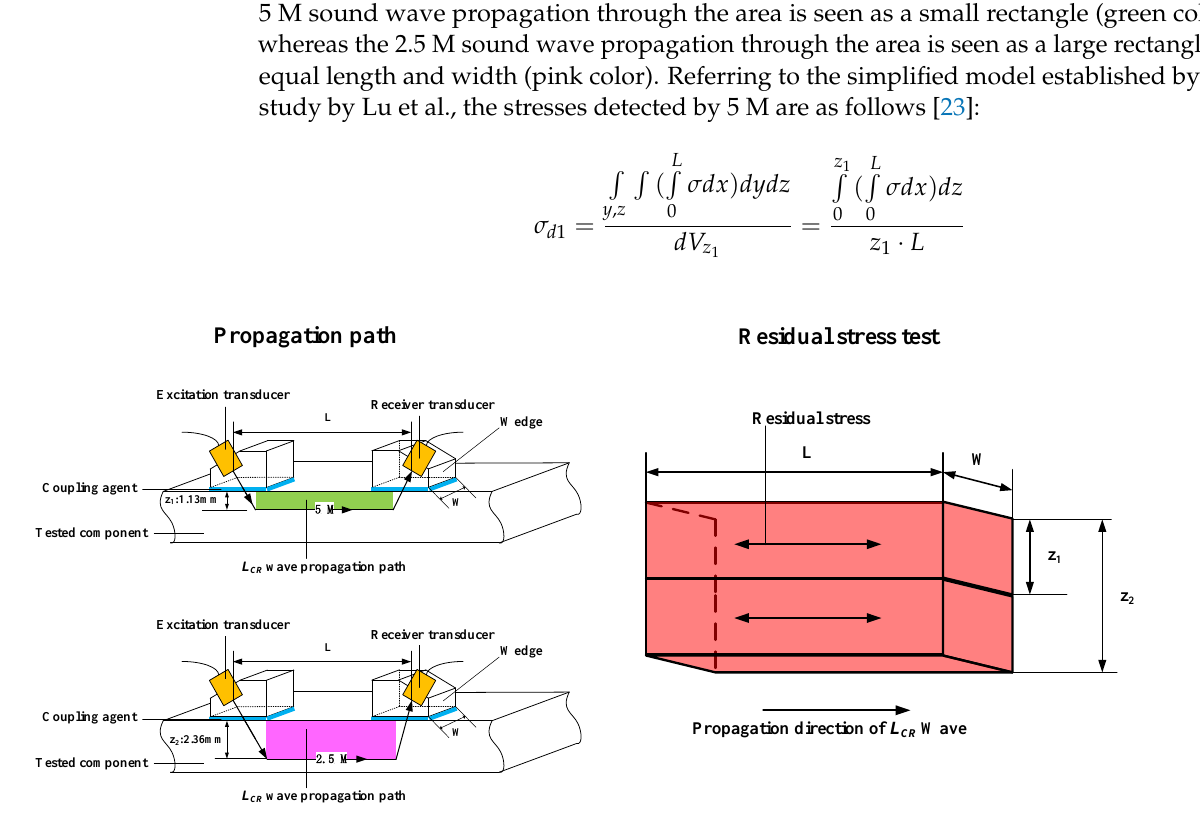
Figure 1. Schematic diagram of ultrasonic propagation path and the depth distribution model of horizontal normal stress.